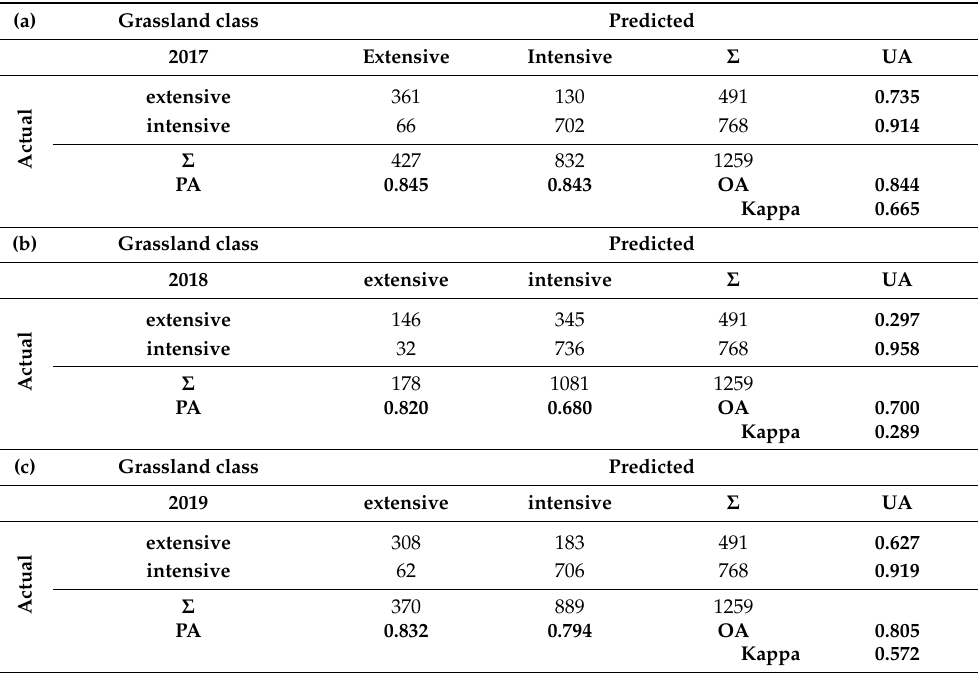
Table 2. Confusion matrices of the annual SITS (Sentinel-1, Sentinel-2) for the accuracy of the